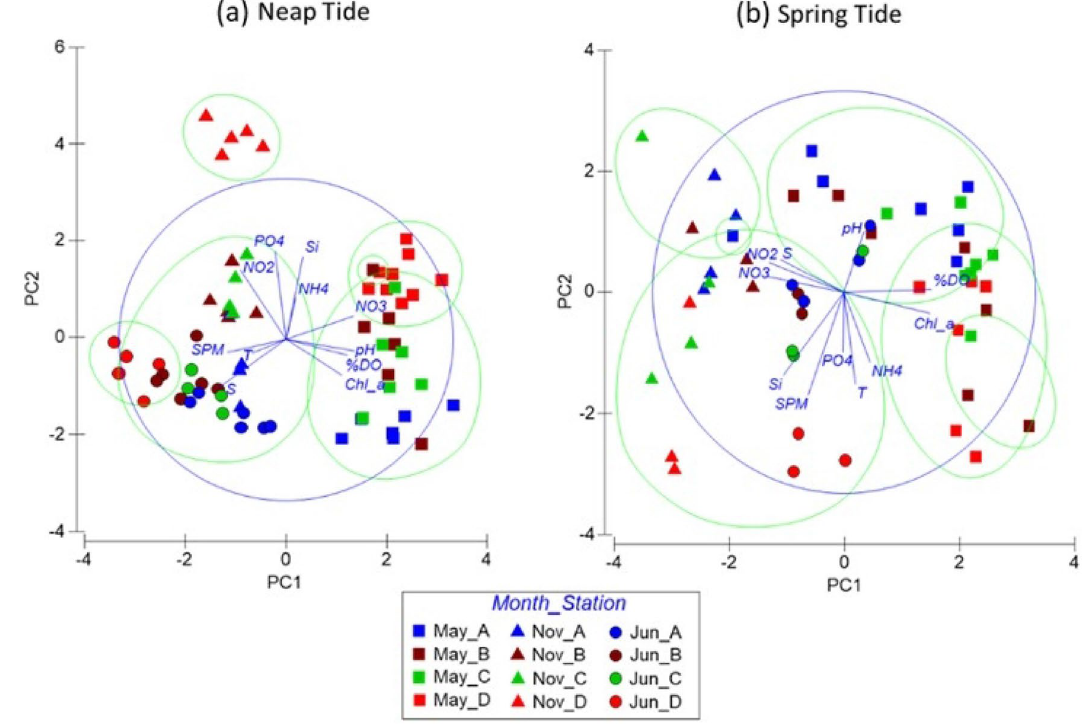
Figure 4. Principal component analysis (PCA) considering the data collected under neap tide and spring tide conditions. Samples classified according to the month of the data collection (May/18, Nov/18 and Jun/19) and the sampling station. T temperature, S salinity, %DO dissolved oxygen, SPM suspended particulate matter, Chl_a chlorophyll a and Si silicate Si(OH) 4 . The figure was produced using PRIMER 6 (6.1.16) + PERMANOVA (1.0.6) software from PRIMER-e (https:// www. primer- e. com/).